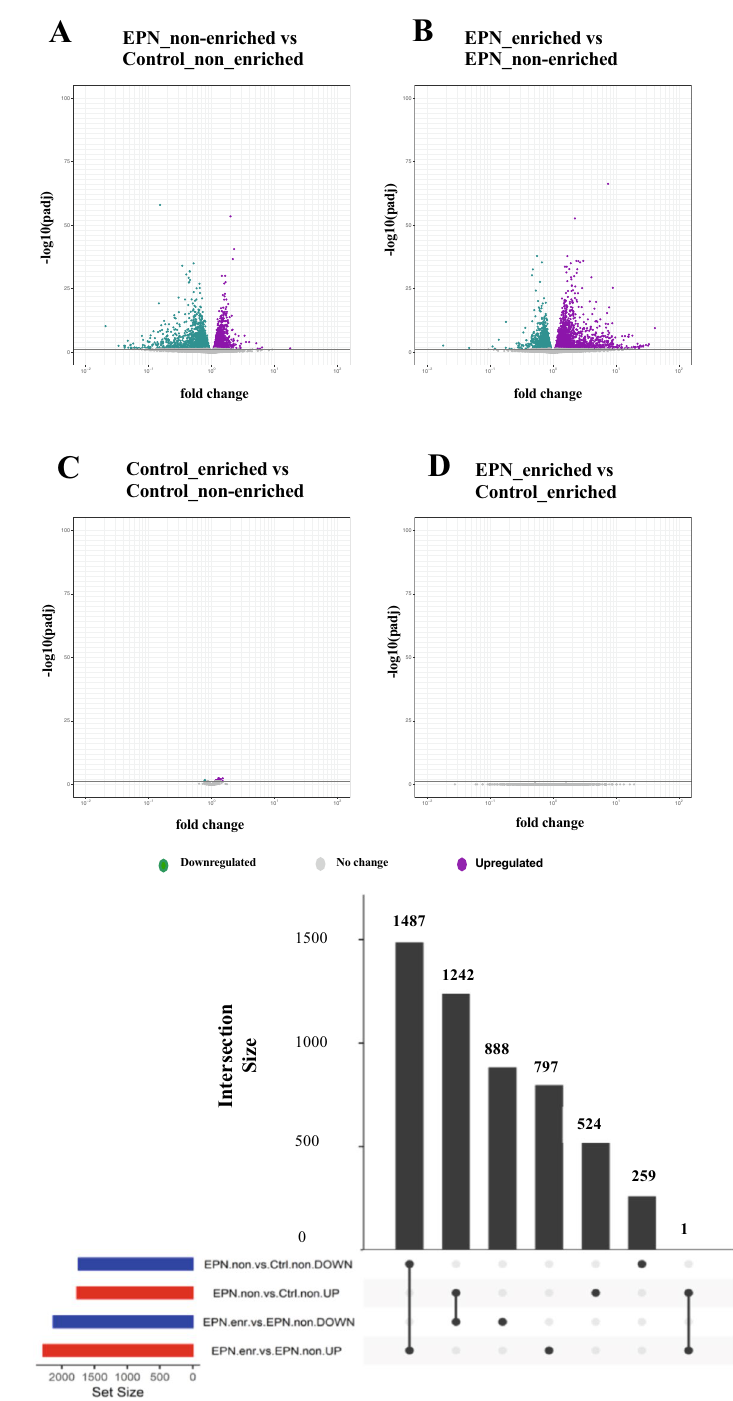
Figure 3. Analysis of differentially expressed genes (DEGs) showed that the Pb-altered transcriptome was further modified by environmental enrichment. ( A – D ) Volcano plots show log2 fold changes and associated p-values for DEGs in the various group comparisons: ( A ) EPN_non-enriched vs Control_non-enriched; ( B ) EPN_enriched vs EPN_non-enriched; ( C ) Control_enriched vs Control_non-enriched; ( D ) EPN_enriched vs Control_enriched. Green colored circles indicate genes that were significantly differentially downregulated; magenta-colored circles indicate genes that were significantly differentially upregulated (FDR < 0.05); grey colored circles indicate genes with expression unchanged. ( E ) Set comparison analysis of DEGs (FDR < 0.05) showed that environmental enrichment largely reversed Pb-induced transcriptome alterations. DEG sets are shown at the bottom with red and blue bars indicating the relative gene set size, where blue highlights downregulation and red highlights upregulation. Connectors joining two DEG set rows indicate overlap between those sets, where the bar heights on the graph represent set intersection sizes (noted by the numbers above each bar). Living in enriched environment resulted in upregulation of 1487 genes that were downregulated due to Pb exposure and downregulation of 1242 genes that were upregulated by Pb